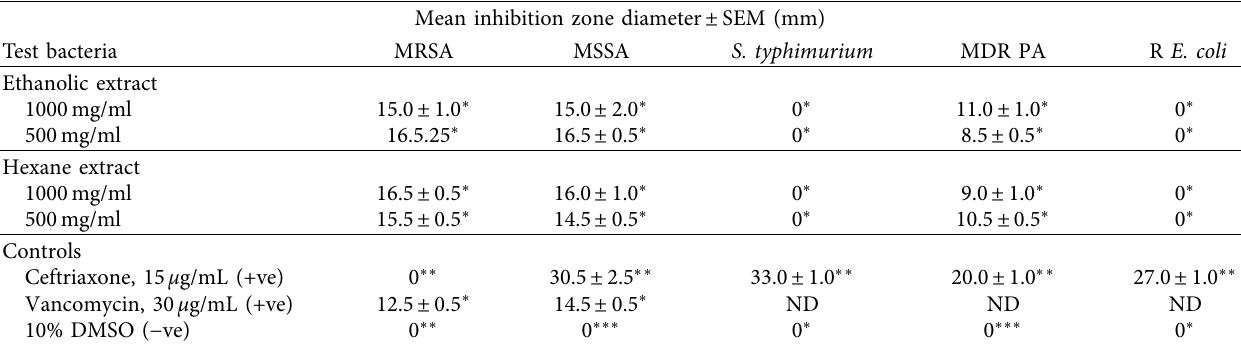
Table 3: Mean and standard error of mean inhibition zone diameters of the ethanolic and hexane crude extract of A. heterophyllus seeds against selected bacteria causing